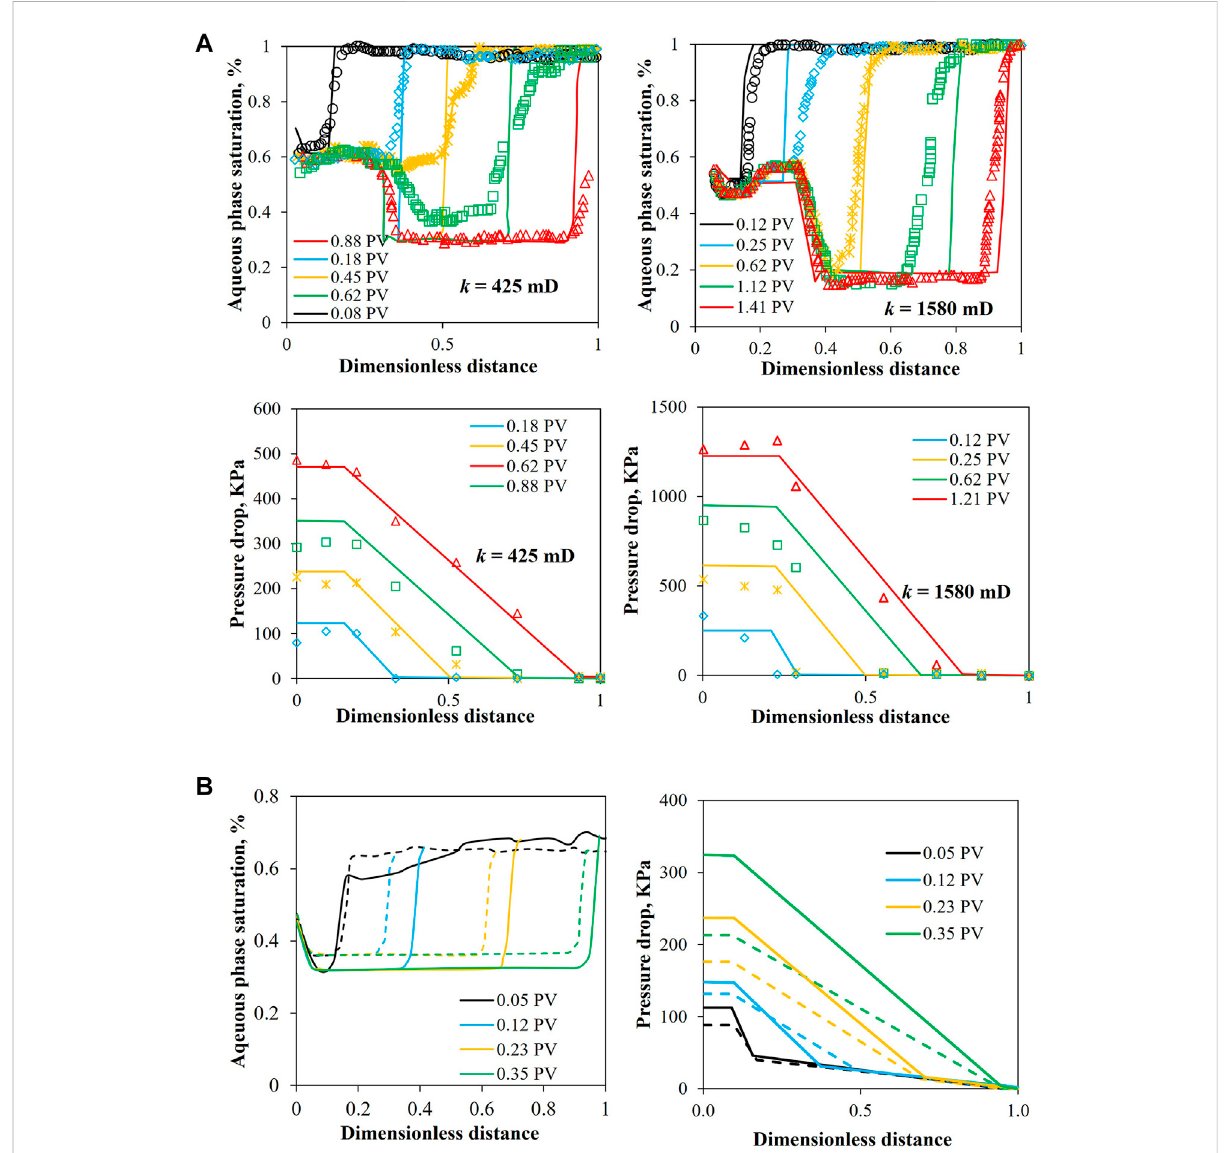
FIGURE 4 (A) Up: measured and predicted aqueous phase saturation pro fi les for oil-free foam fl ow in cores with permeabilities of 425 and 1,580 mD. Down:measuredandpredictedpressuredroppro fi lesforoil-freefoam fl owincoreswithpermeabilitiesof425and1,580 mD. (B) Predictedaqueous phase saturation pro fi le and pressure drop pro fi le in cores with permeabilities of 425 (dashed lines) and 1,580 mD (dotted lines) in the presence of residual